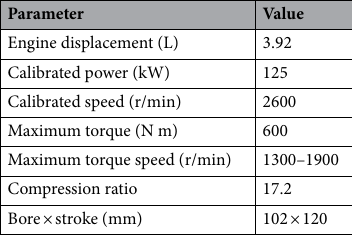
Table 1. Main parameters of the